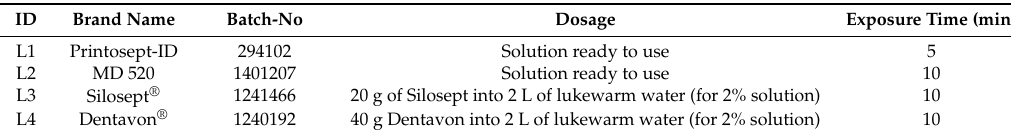
Table A1. Preparation and disinfection times for tested disinfectants.